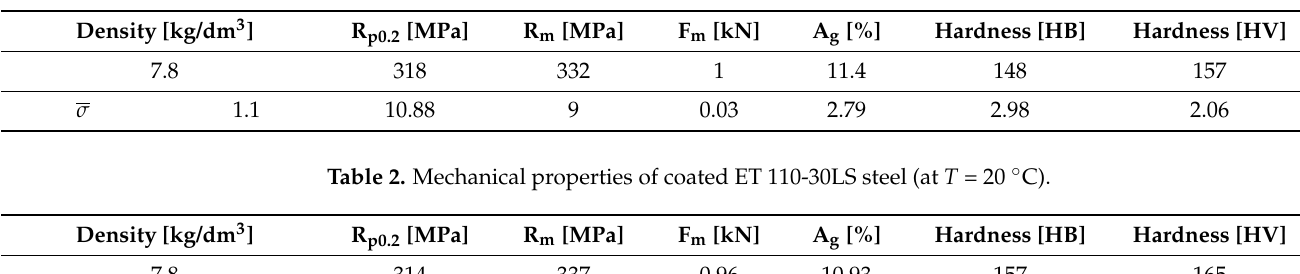
Table 1. Mechanical properties of non-coated ET 110-30LS steel (at T = 20 ◦ C).